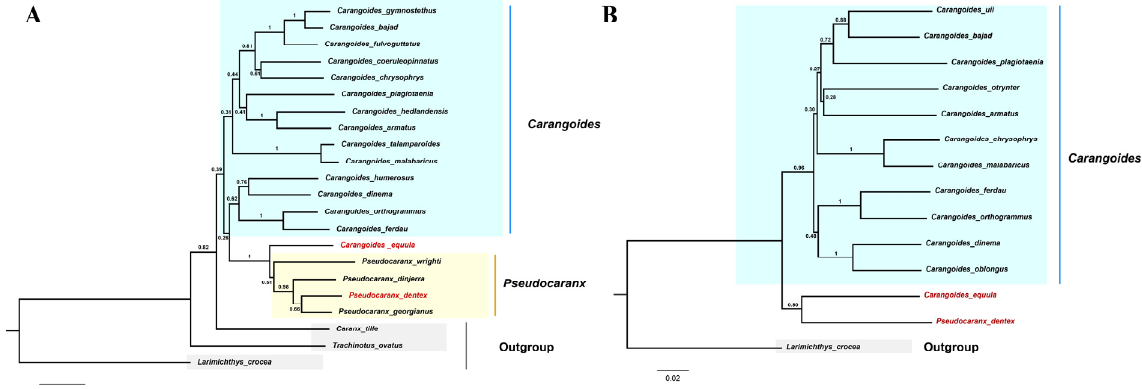
Figure 6. Neighbor-Joining trees based on COI ( A ) and CYTB ( B ) sequences from the Carangoides and Pseudocaranx genera together with C. equula . The numbers at the nodes were the bootstrap support values. P. dentex and C. equula were labeled in red. ( A ) C. tille , T. ovatus, and L. crocea COI sequences were set as outgroups. ( B ). L. crocea was an outgroup.